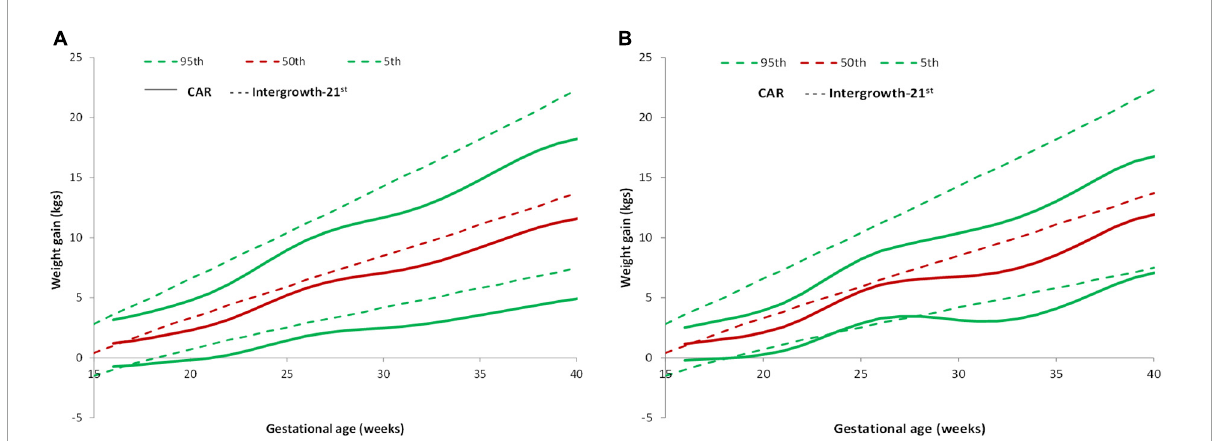
FIGURE4 Pattern of GWG and their comparison with Intergrowth-21st standard. (A) Comparison of GWG curves of the REVAMP cohort ( n = 640) with Intergrowth-21st by gestational age. (B) Comparison of GWG curves of the REVAMP cohort low-risk population ( n = 102) with Intergrowth-21st reference.